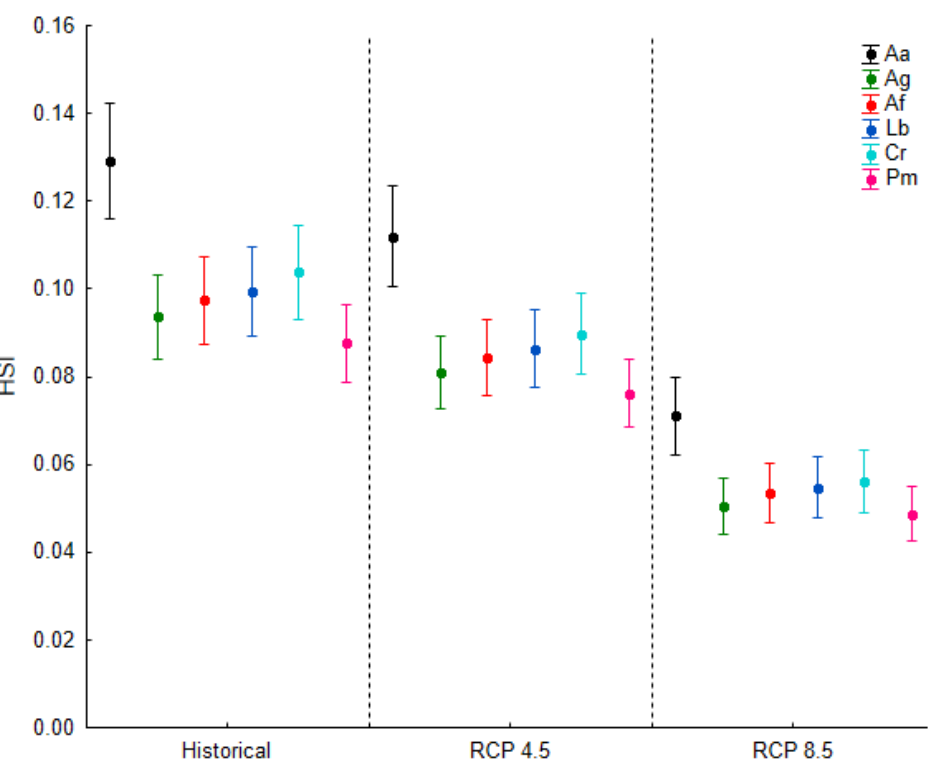
Figure 4. Habitat suitability index (HSI) in each scenario for each species: Alosa alosa (Aa), Anguilla anguilla (Ag), Alosa fallax (Af), Luciobarbus bocagei (Lb), Chelon ramada (Cl), Petromyzon marinus (Pm). Mean values and 95% confidence intervals are given by dots and whiskers, respectively.